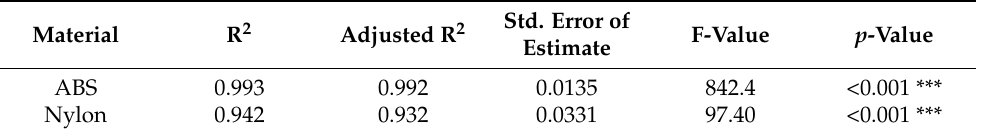
Table 7. Model summary results for fatigue life in terms of logarithmic scale. Std. Error of Material R 2 Adjusted R 2 F-Value p -Value Estimate ABS 0.993 0.992 0.0135 842.4 <0.001 *** Nylon 0.942 0.932 0.0331